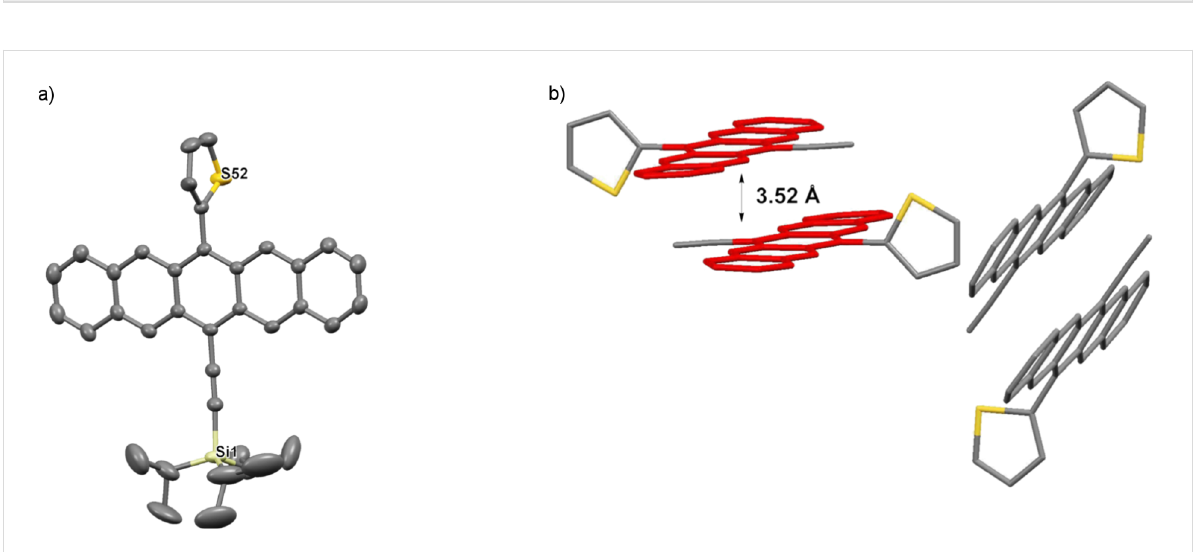
Figure 7: X-ray crystallographic analysis of 3c showing a) molecular structure and b) packing motif (triisopropylsilyl groups omitted for clarity); ORTEP drawn at 50% probability level.